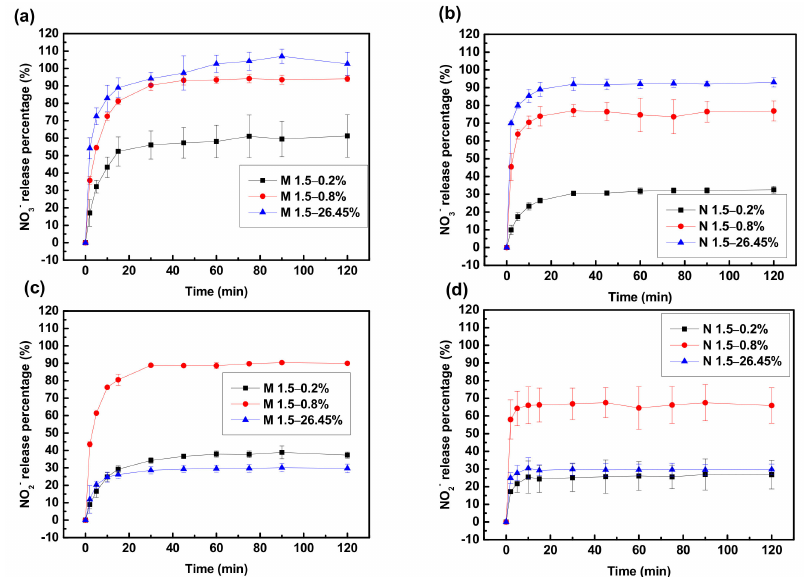
Figure 8. Time course of desorption of nitrate and nitrite from M 1.5 and N 1.5 using different concentrations (0.2 wt %, 0.8 wt % and 26.45 wt %) of NaCl solution. Nitrate releasing percentage (%)